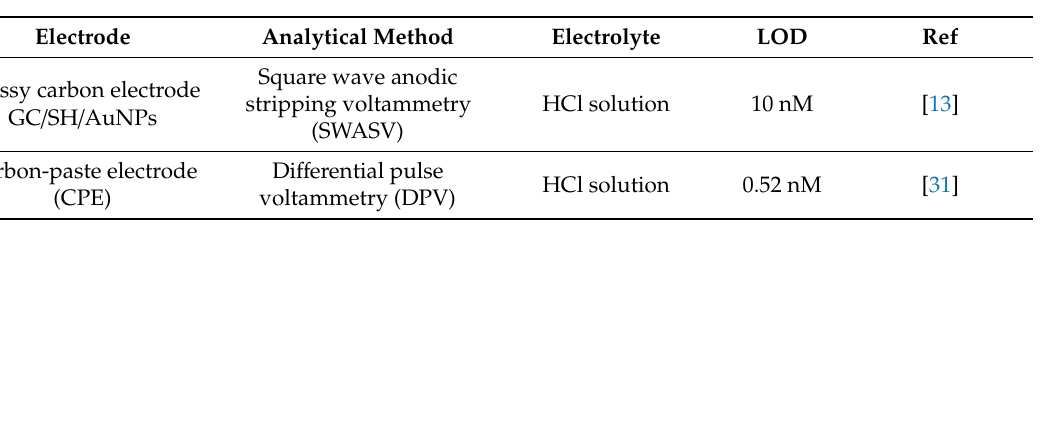
Table 2. Comparison of the analytical performance of Au-ZnO / Hg-IIP to that of other handpicked relevant sensors reported in the